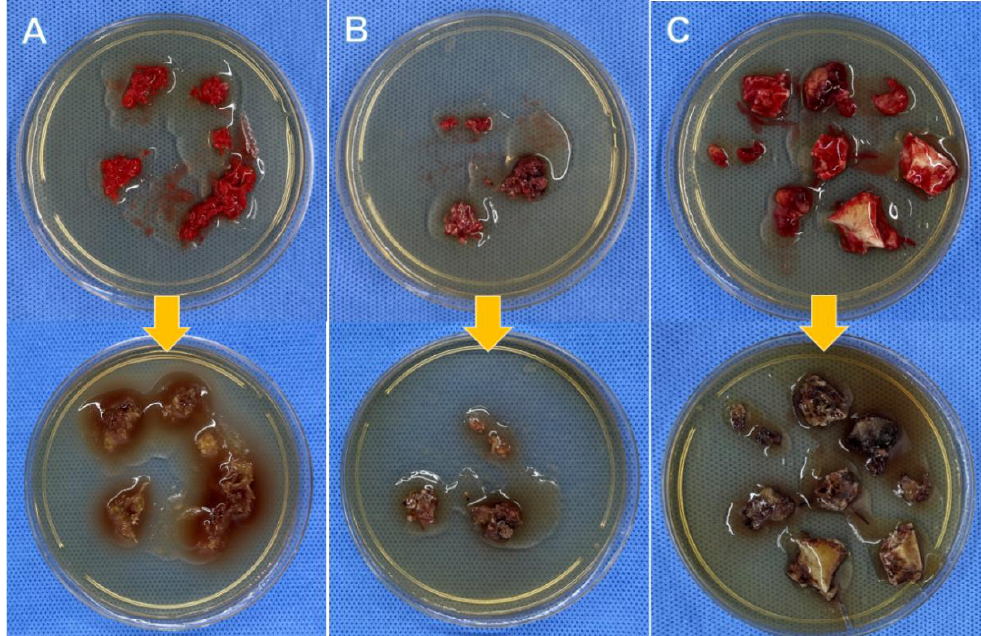
Figure 5. Three OM patients revealed negative outcomes by the BSC method (images in the upper row: the initial stage of BSC; images in the lower row: the end stage of BSC). Panel ( A ): 15-year-old, male, tibia OM, TSC: negative. Panel ( B ): 32-year-old, male, tibia OM, TSC: negative. Panel ( C ): 37-year-old, male, tibia OM, TSC: negative.